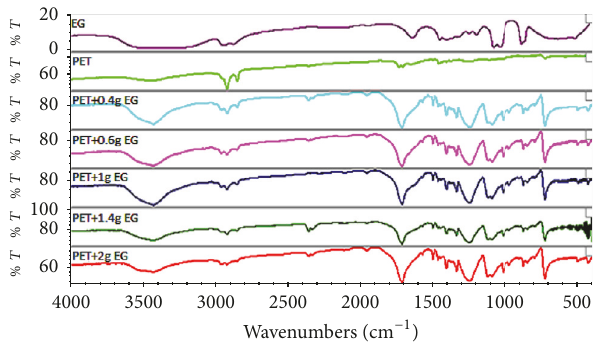
Figure 1: FT-IR spectra of the untreated and treated PET with different mass (grams) of ethylene glycol